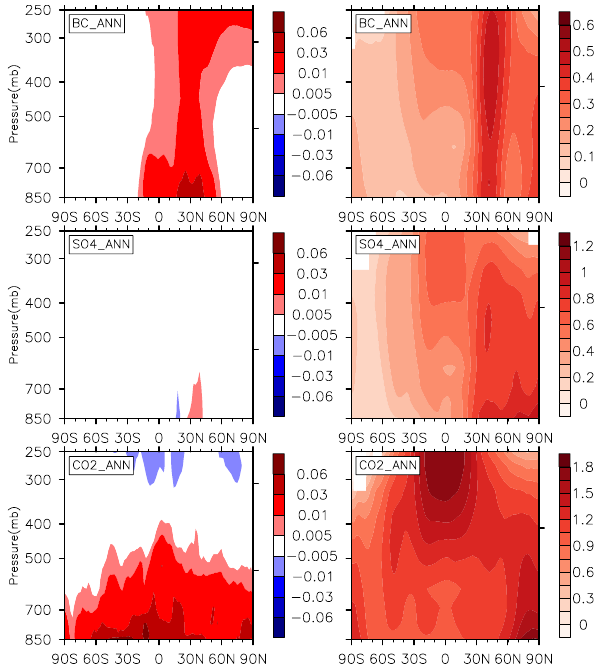
Figure 1. (Left) Heating rate ( ◦ Cday − 1 ) due to an increase in BC, SO 4 and CO 2 atmospheric concentrations. The heating rate is diag- nosed by contrasting two sets of 5-year atmospheric-only simula- tions with pre-industrial and present-day emissions/concentrations, respectively. (Right) Annually averaged atmospheric temperature in response due to the forcing of BC, SO 4 and CO 2 . The color scale for SO 4 is reversed. The magnitude of the color scale is chosen con- sidering the difference in top-of-atmosphere forcing (Table S1).